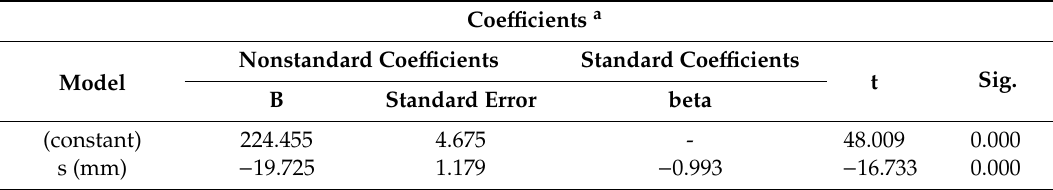
Table 13. Linear regression coefficients for wheel-tracking test and first modulus of PLT ( ɸ 600mm) at crown.